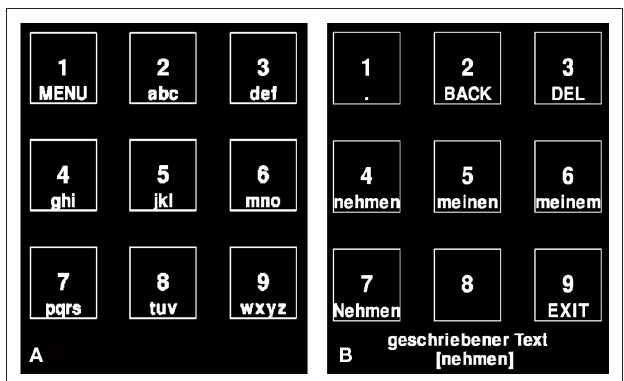
FIguRE 3 | Screenshots of the spelling mode (A) and the control mode